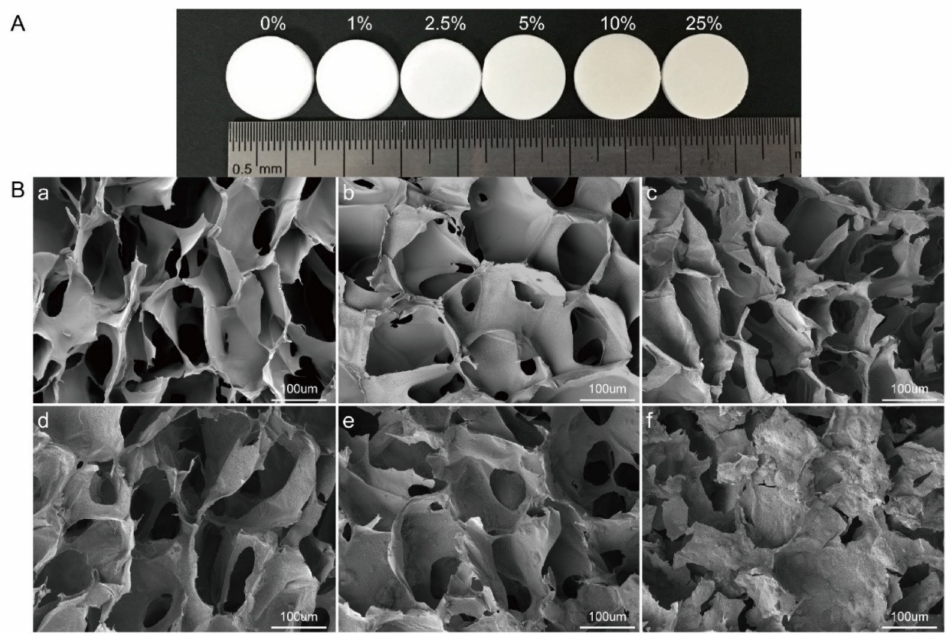
Figure 9. ( A ) Photograph of HYH–chitosan–CaCO 3 scaffolds with different proportions of CaCO 3 . ( B ) Pore morphology of HYH–CaCO 3 scaffolds imaged by SEM. ( a – f ) show the morphology of scaffolds with 0%, 1%, 2.5%, 5%, 10%, and 25% CaCO 3 , respectively. Reproduced with permission